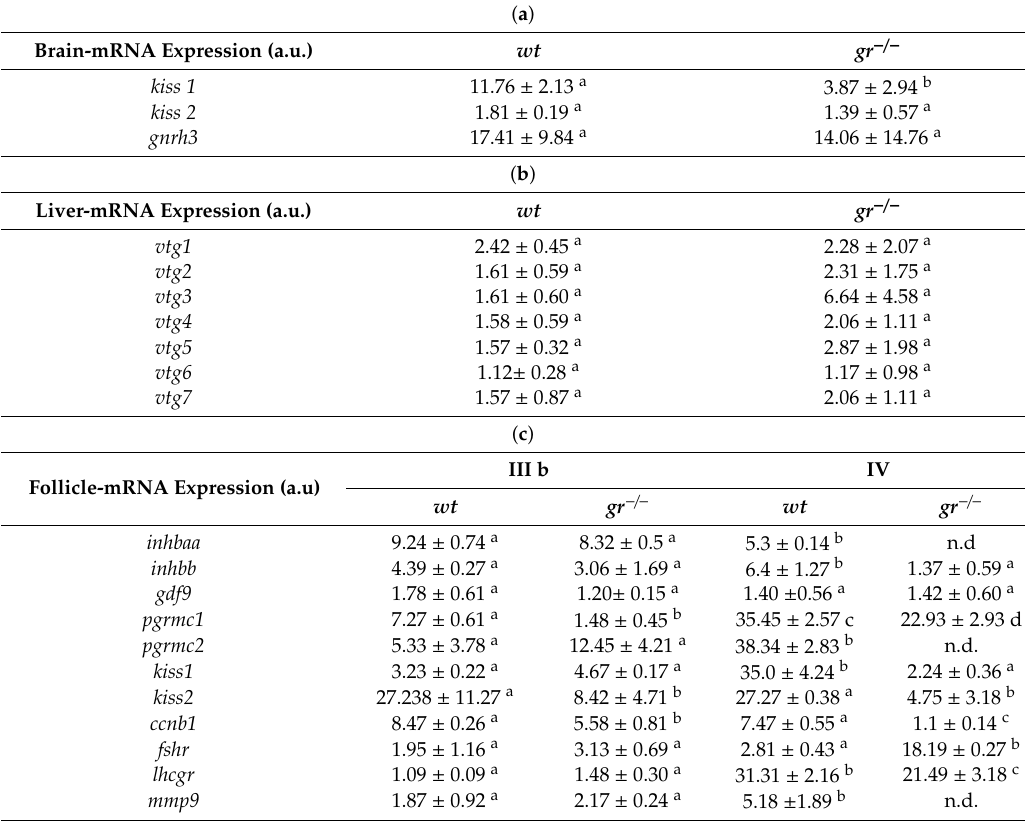
Table 1. ( a ) KiSS-1 metastasis suppressor ( kiss1), kisspeptin 2 ( kiss2), gonadotropin releasing factor 3 (gnrh3) mRNA values normalized against ribosomal protein 0 ( rplp0) and ribosomal protein 13 ( rpl13) in the brain of wt and gr − / − females. ( b ) Vitellogenin (vtg) mRNA values normalized against rplp0 and rpl13 in the liver of wt and gr − / − female. ( c ) β Aa (inhbaa), β B ( inhbb), growth di ff erentiation factor 9 ( gdf9), progesterone receptor membrane component 1 (pgrmc1), progesterone receptor membrane component 2 ( pgrmc2), kiss1, kiss2, cyclin B1 (ccnb1), follicle stimulating hormone receptor ( fshr), luteinizing hormone / choriogonadotropin receptor (lhcgr), matrix metallopeptidase 9 (mmp9) mRNA values normalized against rplp0 and rpl13 in class IIIb and IV follicles isolated from wt and gr − / − ovaries. Values are presented as arbitrary units (a.u.) and are expressed as means ± S.D. Di ff erent letters denote significant di ff erences among experimental groups ( p <